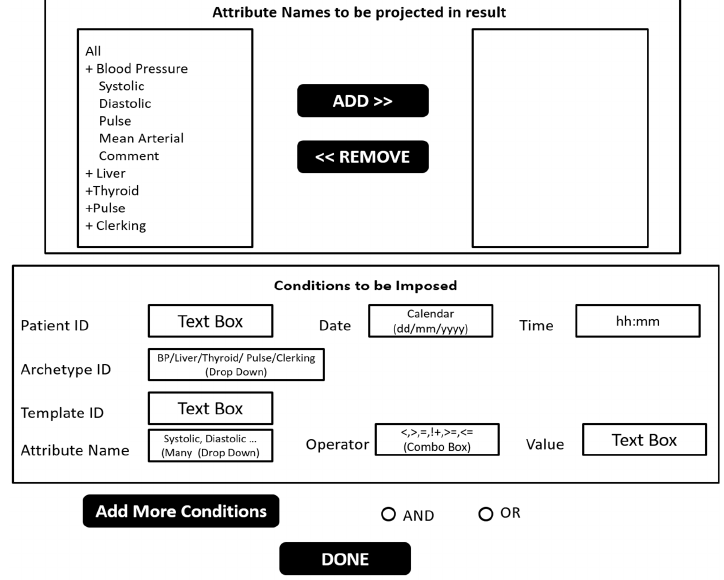
Figure 4. A Blueprint of query interface for the Two Dimensional Entity Attribute Value (2D EAV) storage